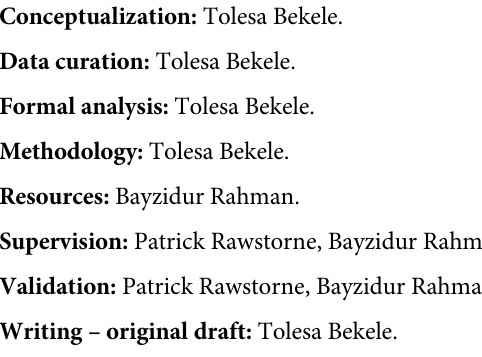
S1 Fig. Geographical variation of CGF in Ethiopia between 2000 and 2016. S1 Table. Predicted probabilities for stunting over the four survey years, EDHS. S2 Table. Predicted probabilities for underweight over the four survey years, EDHS. S3 Table. Predicted probabilities for wasting over the four survey years,